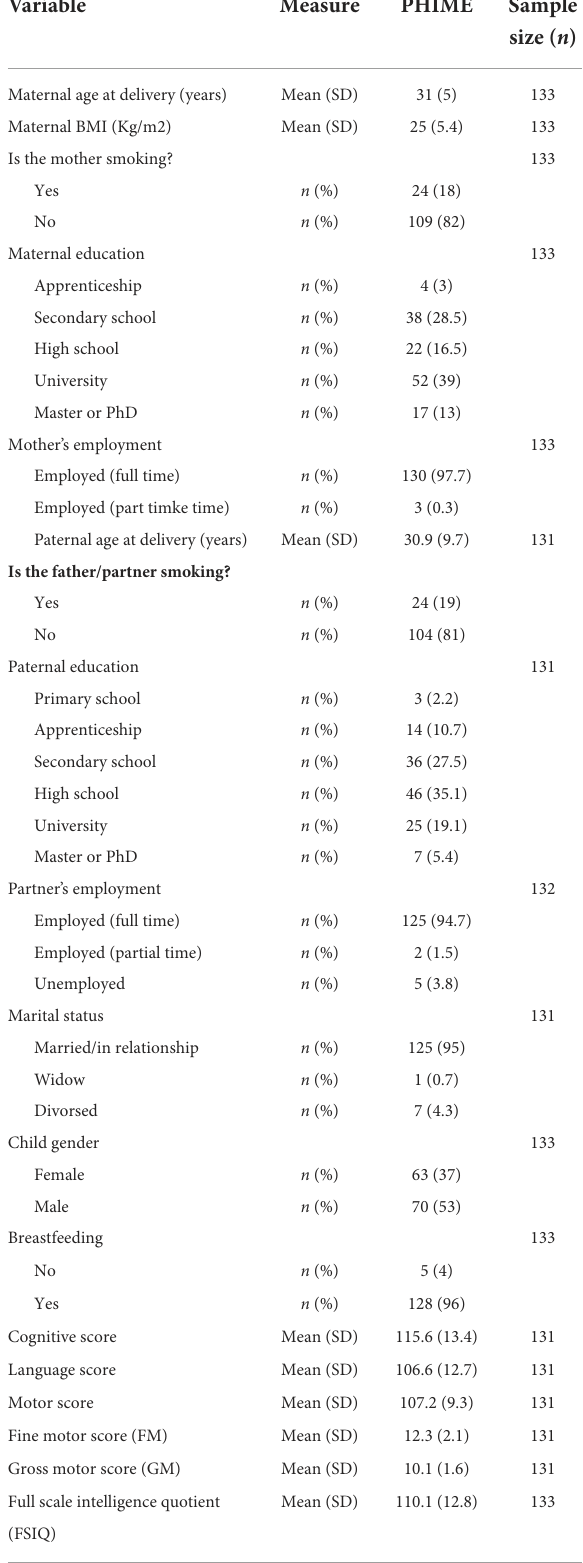
TABLE 1 Characteristics of the study population (PHIME Cohort), and Bayley scores for cognitive, language and motor Bayley-III scores (29).